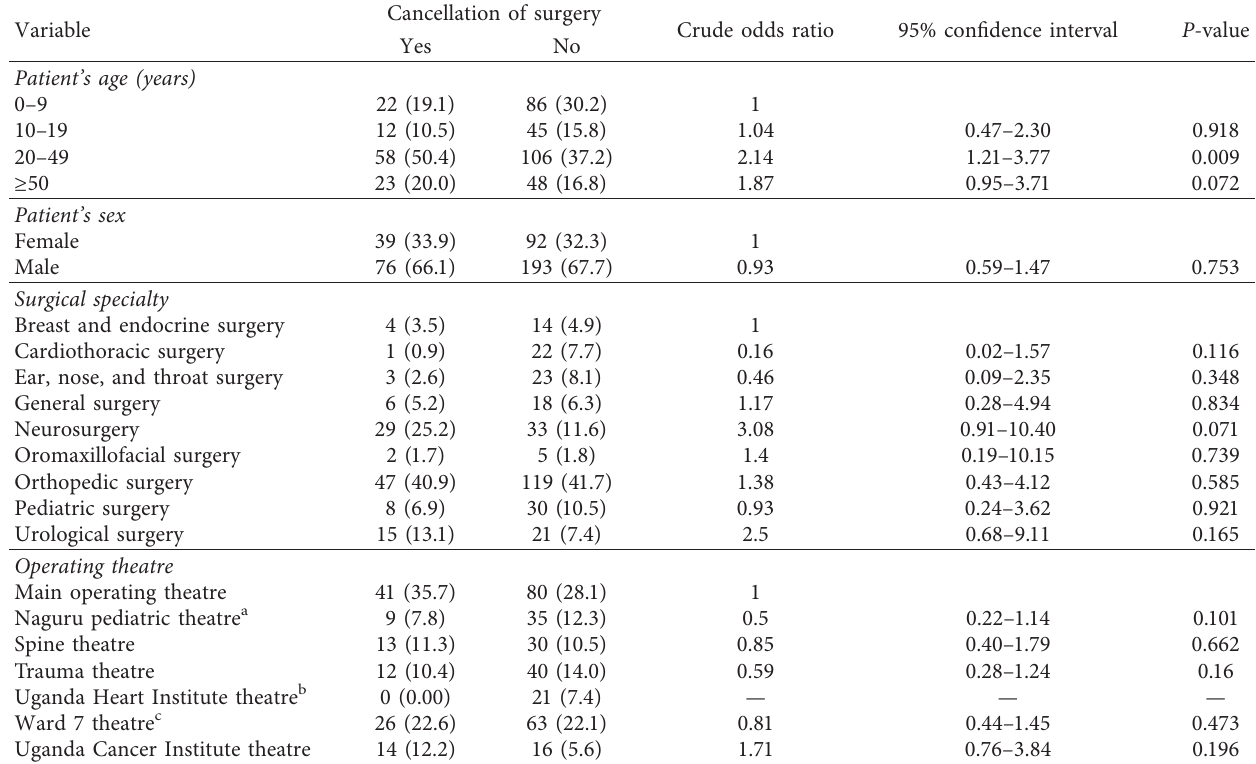
Table 3: Bivariate analysis of factors associated with cancellation of elective procedures in surgical wards at Mulago Hospital, Uganda. Variable